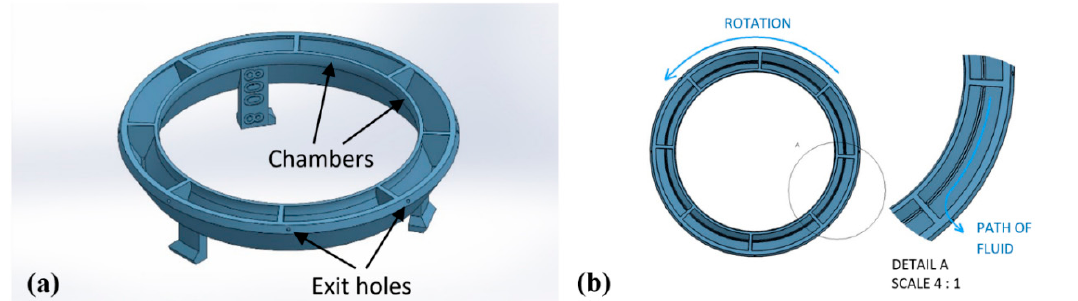
Figure 3. Spinneret interior design, showing: ( a ) multiple chambers and exits and ( b ) the fiber production process.